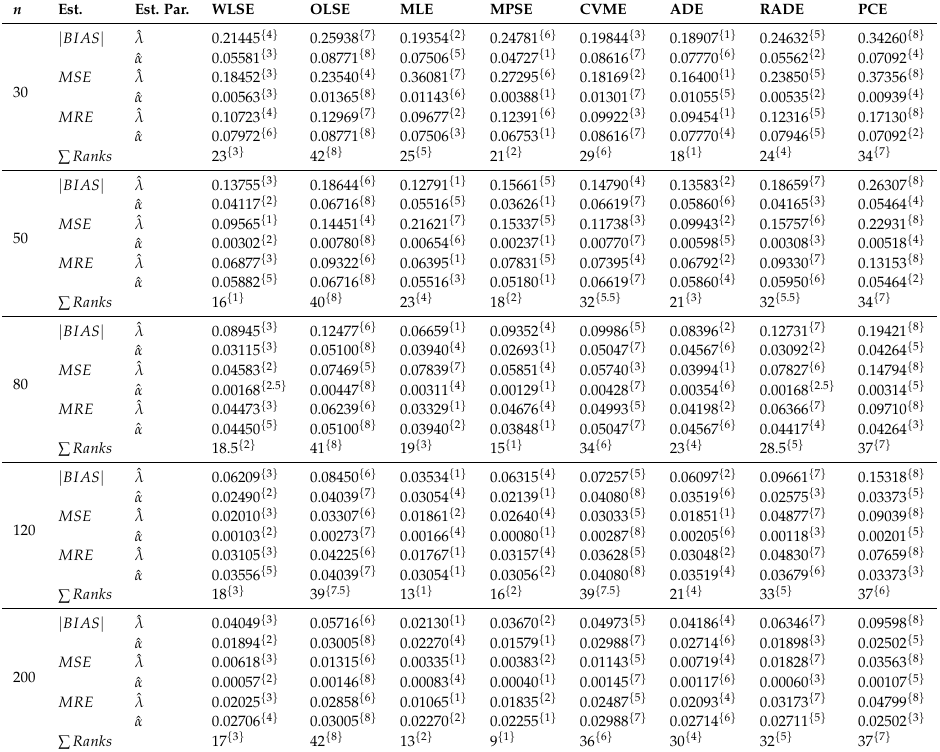
Table 4. Simulation results for φφφ = ( λ = 2.0, α = 0.7 ) (cid:124) .